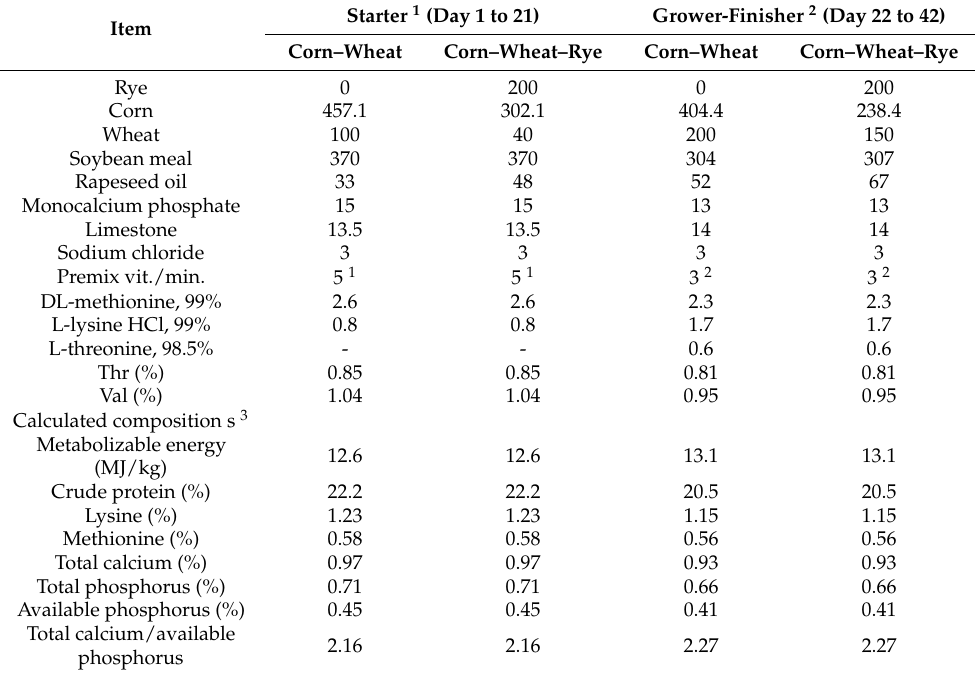
Table 1. Composition (g/kg) and nutritive value of the experimental diets *. Item